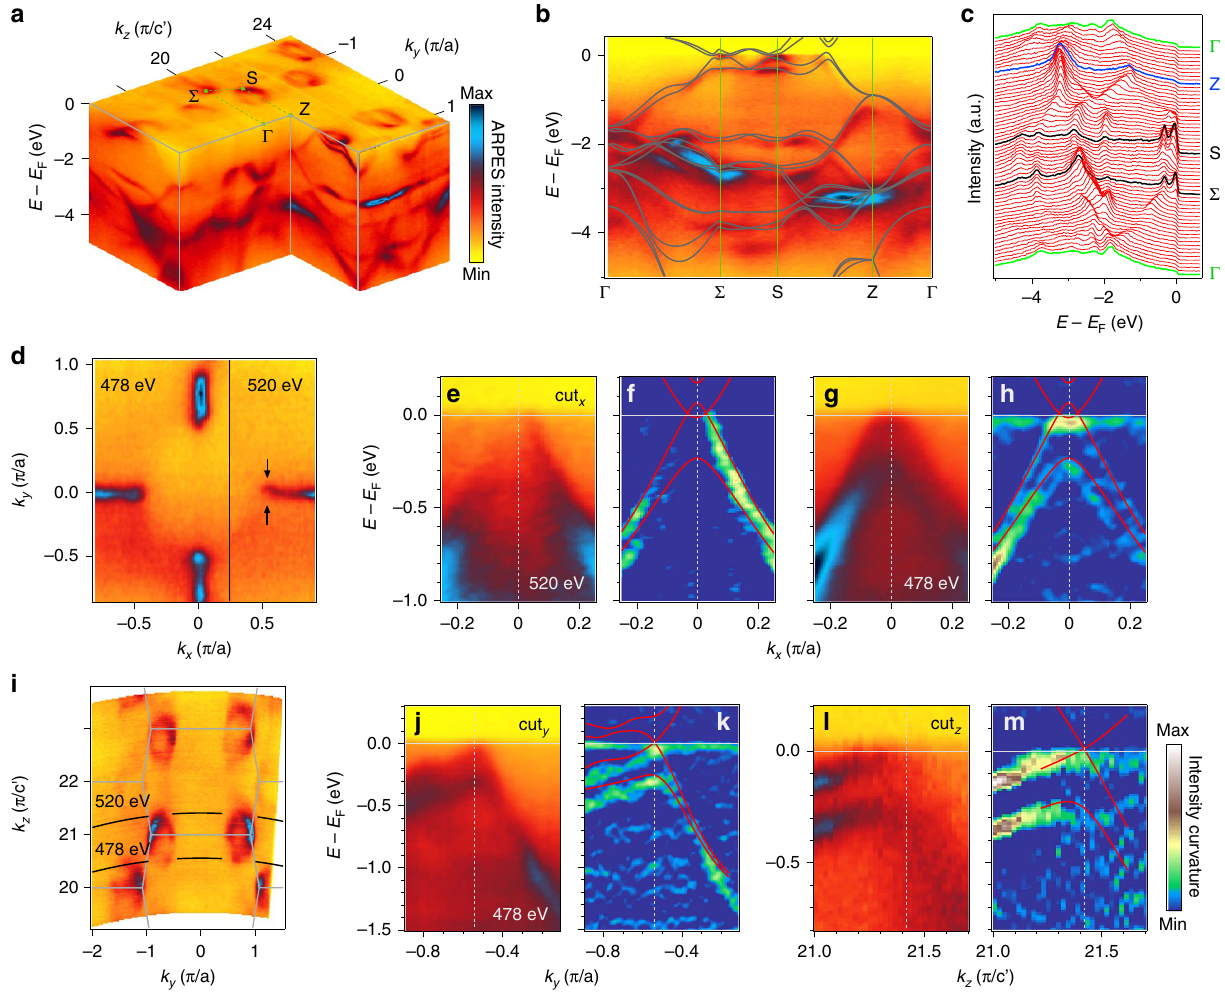
Figure 2 | Bulk electronic structures and W1 type of Weyl cones in TaP. ( a ) Photoemission intensity of the bulk electronic states as a function of energy relative to Fermi level in the k y -k z plane. ( b , c ) The ARPES spectrum and the energy distribution curves along the high-symmetry lines G - S -S-Z- G . The calculated bands are overlaid on top of the spectrum in b for comparison. ( d ) Fermi surface map in the k x - k y plane at k z ¼ ± 0.58 p / c’ , taken with hv ¼ 478 and 520eV. ( e , f ) ARPES intensity plot and its curvature plot with calculated bands overlaid on top. The data were acquired with h n ¼ 520eV along cut x passing through W1. ( g , h ) Same as e and f , but the data were acquired with h n ¼ 478eV. ( i ) Fermi surface map in the k y - k z plane at k x ¼ 0, the data were acquired with soft X-ray. ( j , k ) and ( l , m ) Same as g , h but along a long cut y and cut z ,